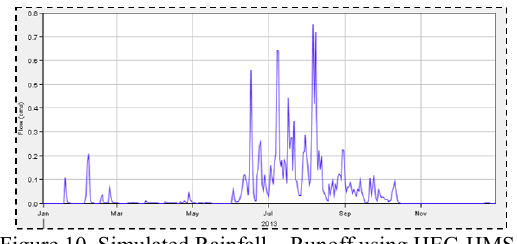
Figure 10. Simulated Rainfall – Runoff using HEC-HMS.